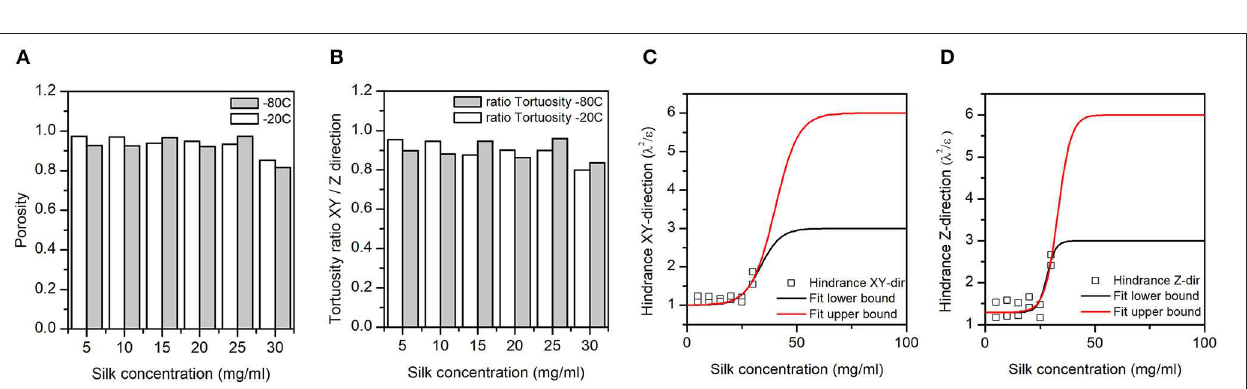
FIGURE 5 | (A) Silk sponge scaffolds’ fractional porosity ( ε ). (B) The ratio of the silk sponge scaffold XY plane to Z-direction tortuosities ( λ ). A ratio of 1 meant no anisotropy in the tortuosity; a ratio < 1 meant a higher tortuosity in the Z-direction as compared to the XY plane. (C,D) Hindrance factor ( λ 2 / ε ) in the XY and Z-directions, respectively. The hindrance, or resistance to flow, is tentatively fitted to a sigmoid with lower and upper bounds (three and six) defined by Bombyx mori cocoon hindrance ( Horrocks et al., 2013). Note that we pulled the − 20 and − 80 ◦ C hindrance together for the fit.